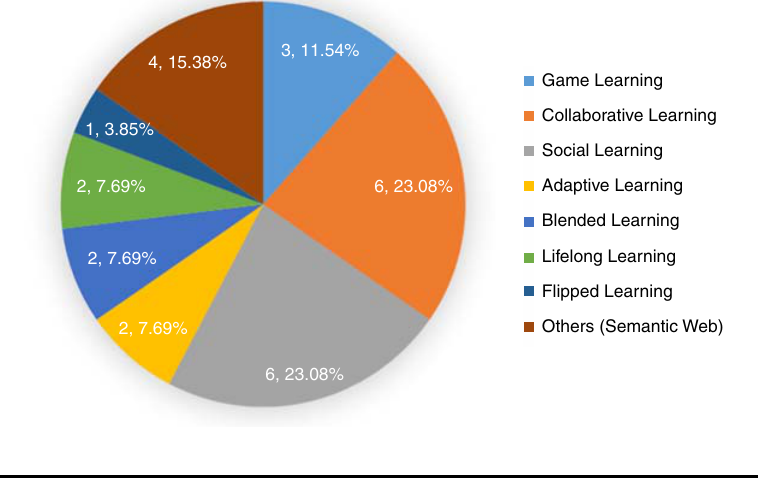
Figure 13. The distribution of